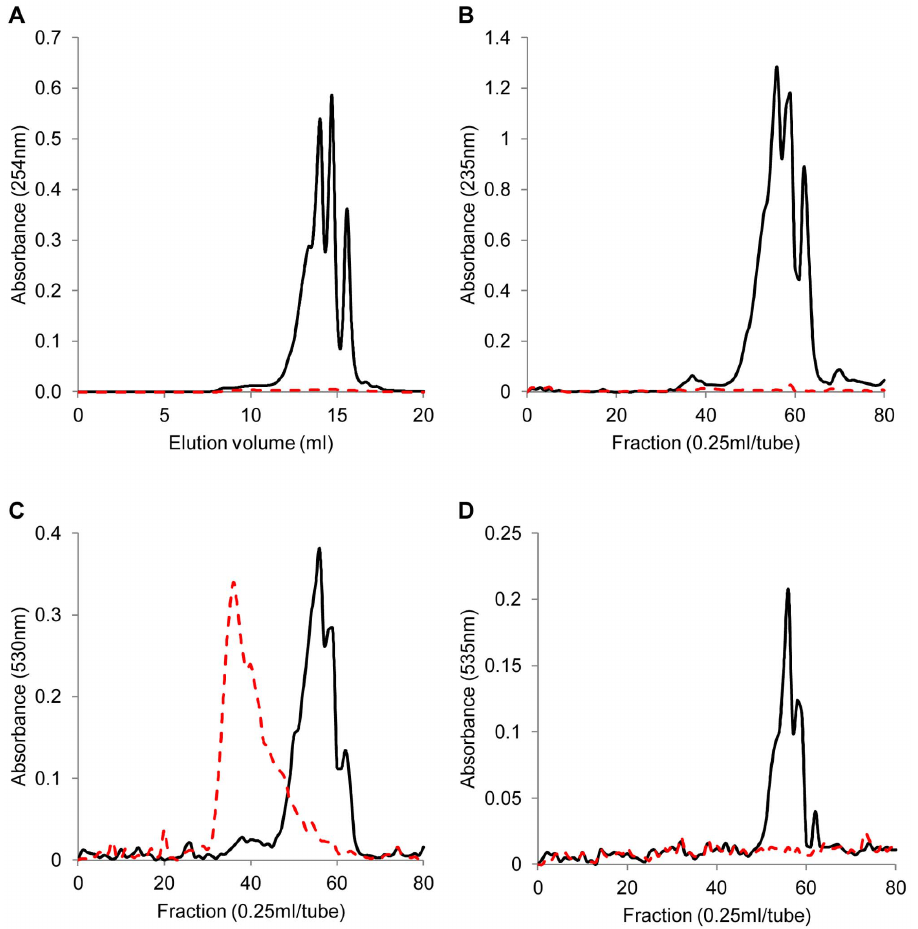
Figure 5. FPLC fractionation and analysis of products from AlgMsp-cleavage of alginate. AlgMsp-cut and uncut alginate are represented by a solid black line and a dashed red line respectively in panels A to D. (A) Real-time FPLC UV-detector trace from absorbance at 254 nm of products eluting from the Superdex Peptide HR10/30 column. (B) Testing of 0.25 ml FPLC fractions for unsaturated uronates by absorbance at 235 nm. (C) Testing of 0.25 ml FPLC fractions for all uronic acids by the carbazole assay with an increase in absorbance at 530 nm. (D) Testing of 0.25 ml FPLC fractions for reducing sugars by the DNS assay with an increase in absorbance at 535 nm.